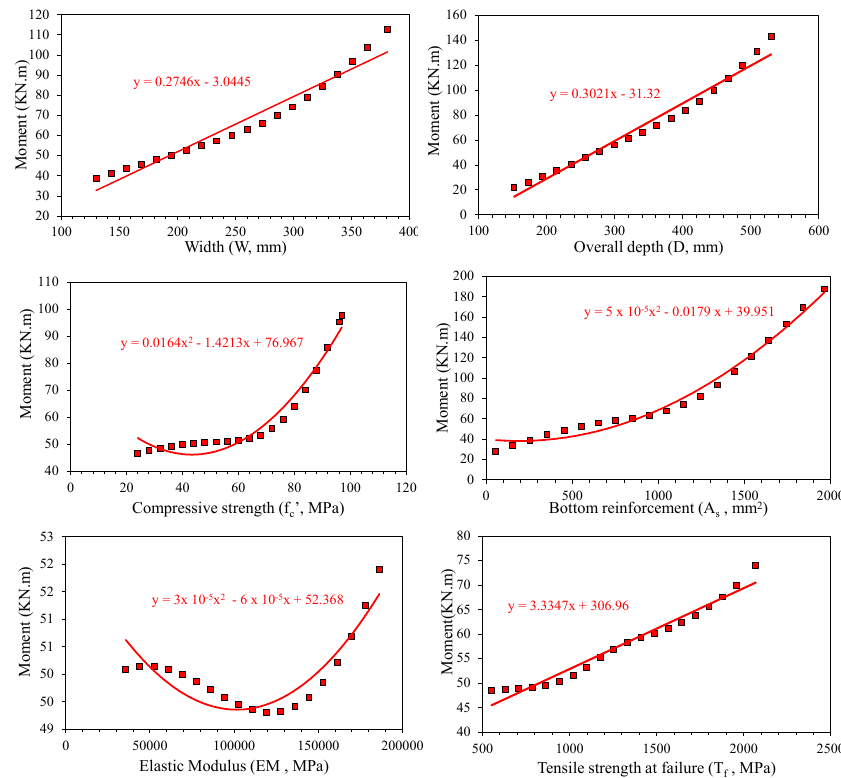
Figure 5. Parametric Analysis of ANN model.